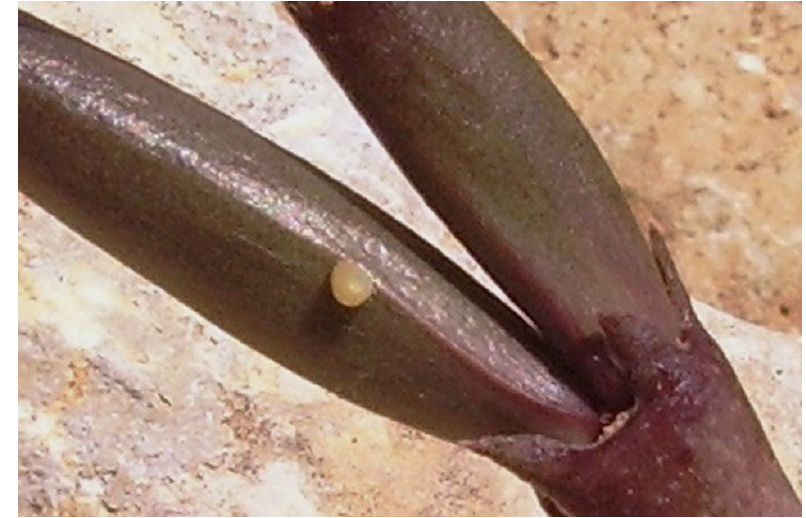
Figure 1. Egg of Danaus chrysippus on a fruit of C. europaea in Lampedusa Island (Photo by P. Zito).